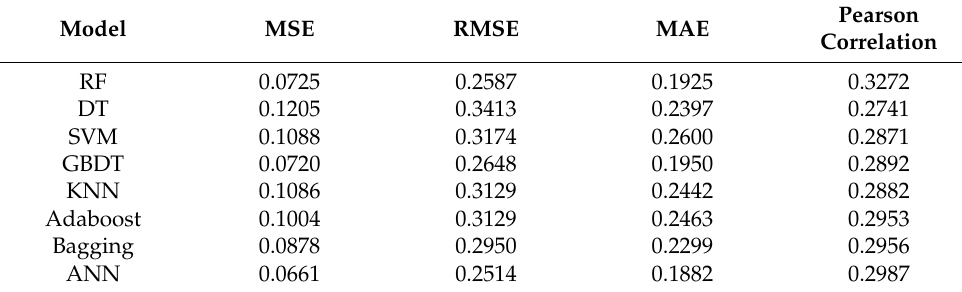
Table 3. Evaluation results of the machine learning methods.